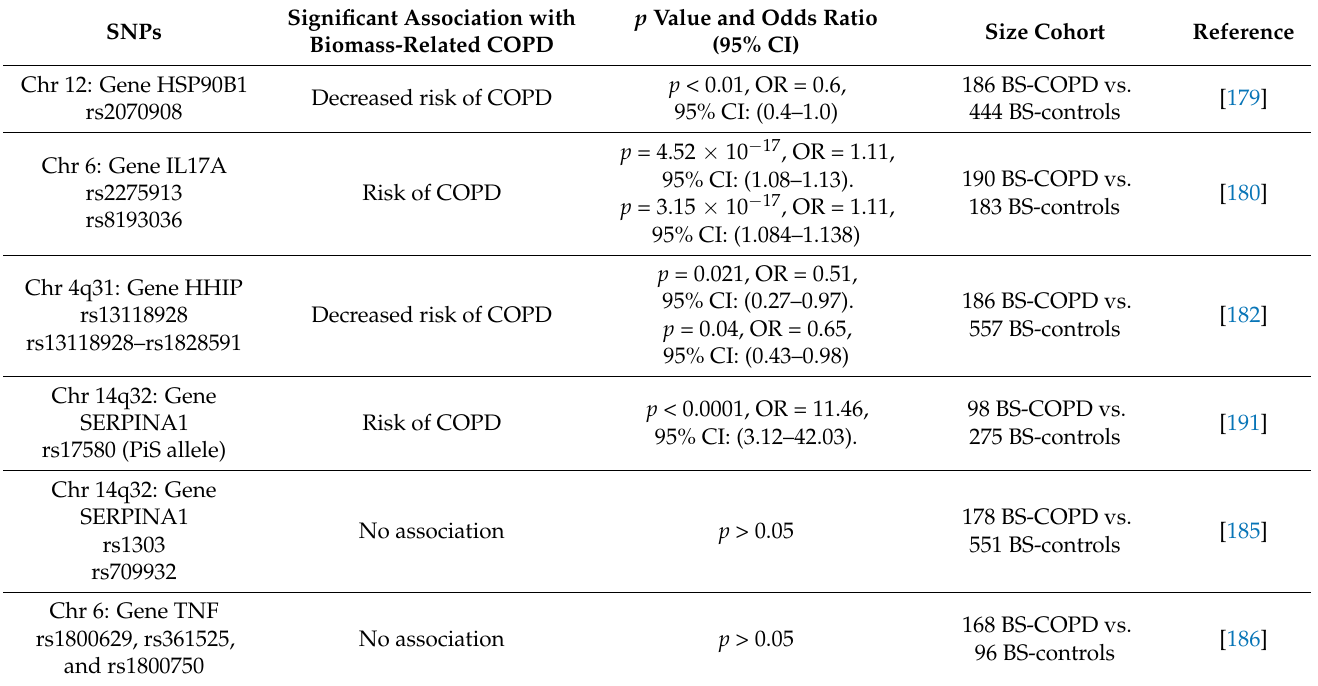
Table 6. Genetic studies of biomass smoke-related COPD (BS-COPD) compared with biomass- exposed healthy controls (BS-controls) in predominantly female populations.